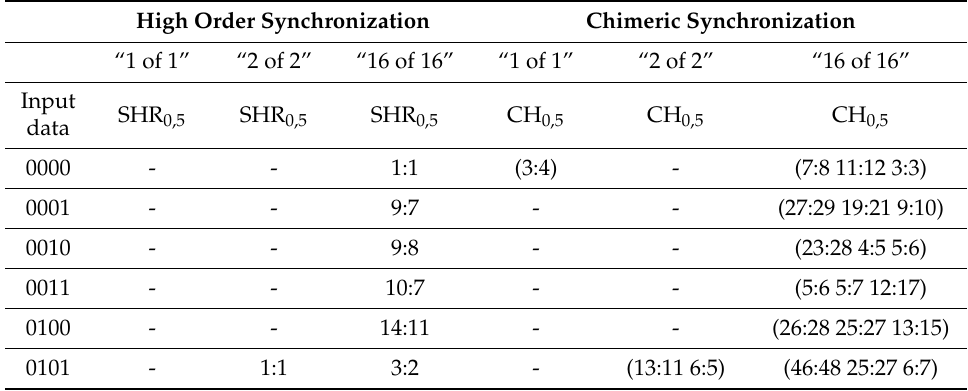
Table 1. Example of network responses for the “ x of x ” task. Empty cells correspond to the absence of synchronization by criterion of Equation (5). The responses are taken at high order SHR 0,5 and chimeric CH 0,5